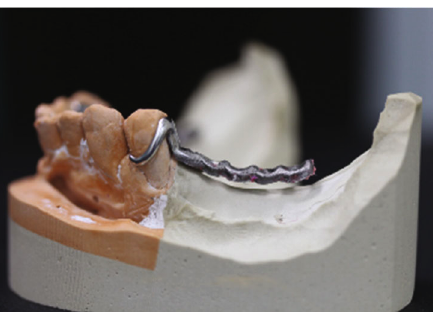
Figure 22: Metal framework on the altered